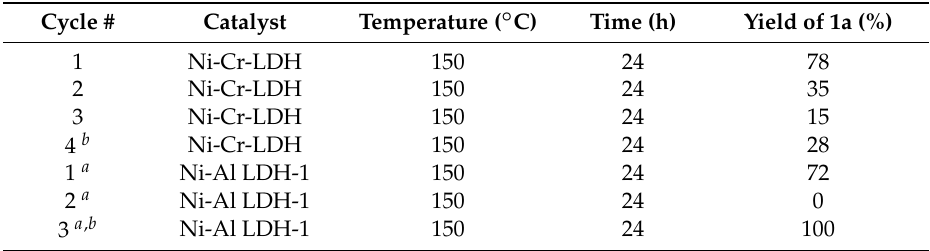
Table 7. Catalyst reusability study in the oxidation of 1 (phenyl ether as solvent).